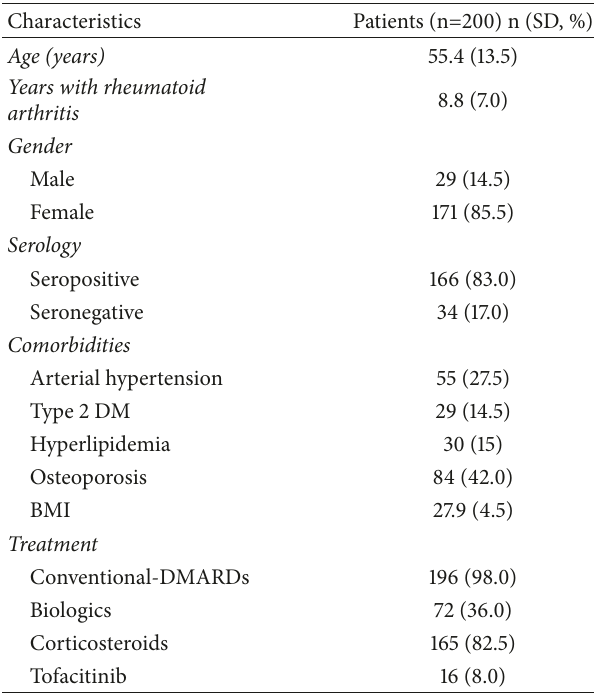
Table 2: Mean scores of rheumatoid arthritis activity assessed by each